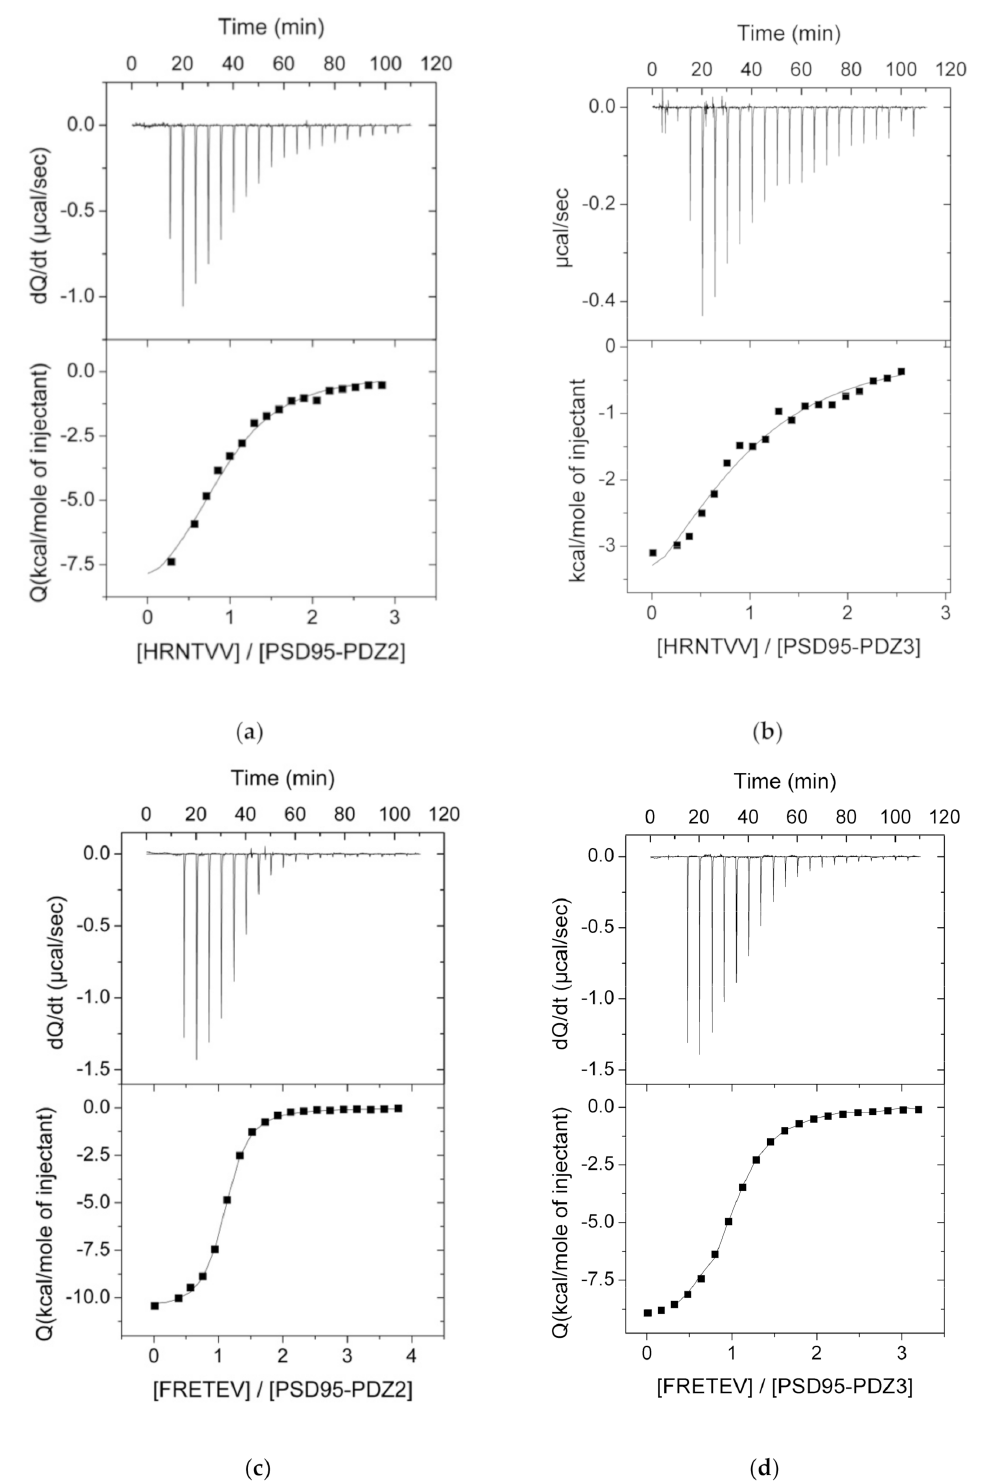
Figure 2. ITC experiments showing previously described interactions between the PDZ domains of PSD95 and both host (ERBB4) and viral (HTLV-1) ligands. Each panel corresponds to: ( a ) HRNTVV (ERBB4) with PSD95-PDZ2; ( b ) HRNTVV (ERBB4) with PSD95-PDZ3; ( c ) FRETEV (HTLV-1) with PSD95-PDZ2; ( d ) FRETEV (HTLV-1) with